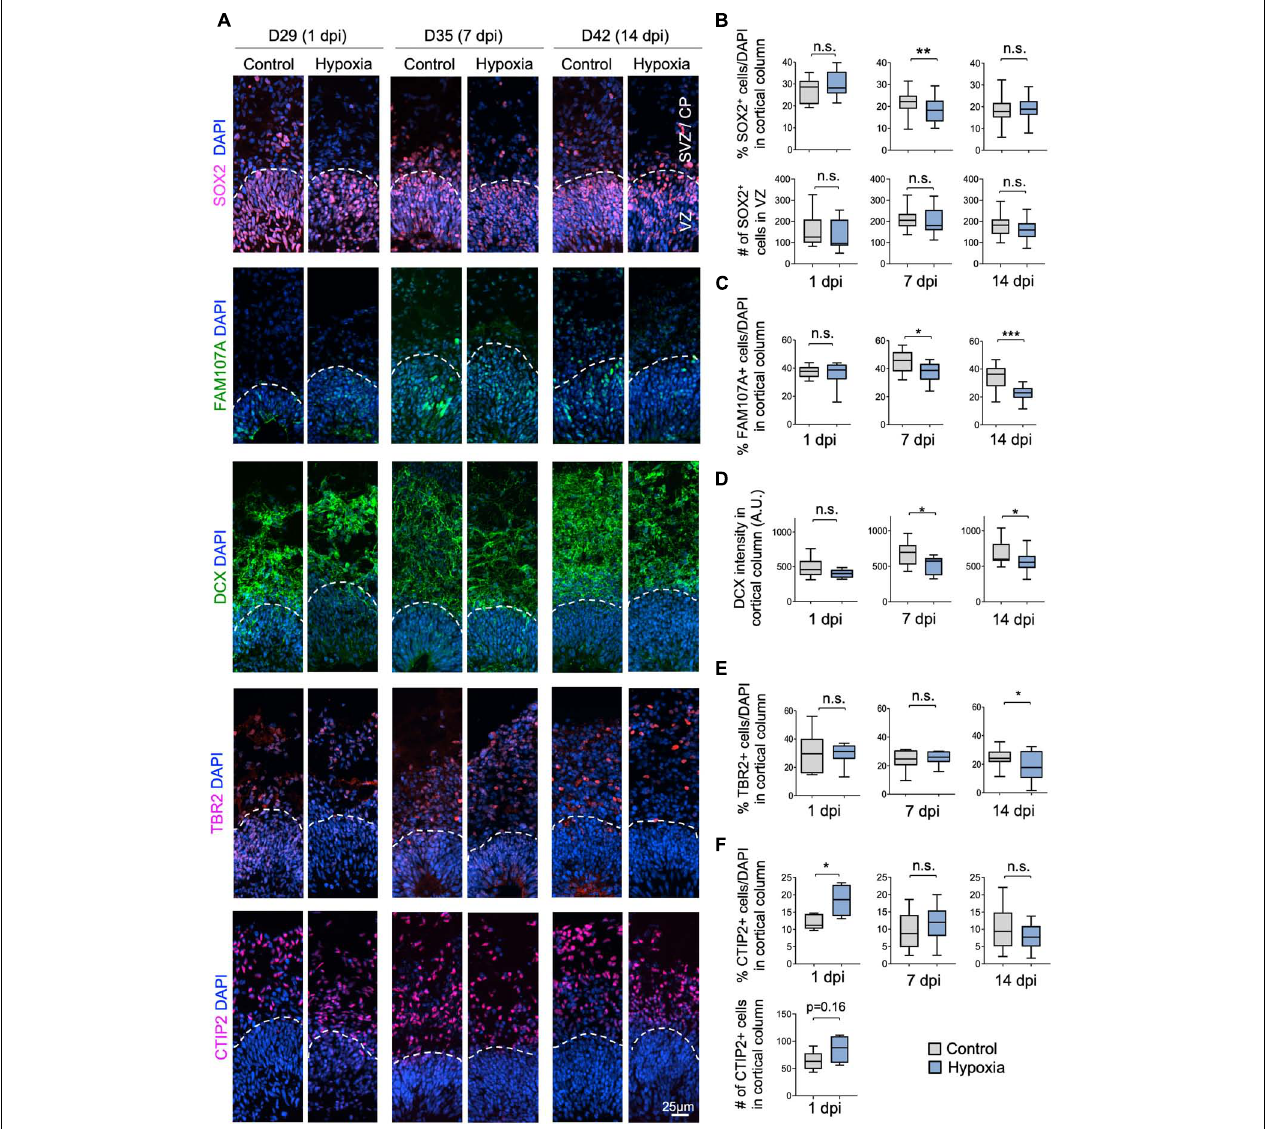
FIGURE 3 | Cellular distinction of different neural populations in response to HI. (A) IF images of representative 100 × 300 µ m cortical columns labeled for the indicated markers at the indicated time points after hypoxia or control. White dashed lines demarcate VZ and outer layers (SVZ/CP). (B) Top graphs: quantifications of the percentage of DAPI + cells across all cortical layers in radial columns that are positive for SOX2 at the indicated time points after hypoxia or control. Bottom graphs: quantifications of the number of SOX2 + cells in VZ-like layer at the indicated time points. Student’s t test, n = 9 organoids from three different batches. (C) Quantifications of the percentage of DAPI + cells in cortical columns that are positive for FAM107A. Student’s t test, n = 9. (D) Quantifications of immunostaining intensity for DCX normalized to unit area (expressed as A.U.). Student’s t test, n = 9. (E) Quantifications of the percentage of DAPI + cells across all cortical layers in radial columns that are positive for TBR2 at the indicated time points after hypoxia or control. (F) Top: quantifications of percentage of DAPI + cells positive for CTIP2 in radial columns. Bottom: quantifications of the number of CTIP2 + cell in radial columns at 1 dpi. Student’s t test, n = 9. A.U., arbitrary unit. ∗ p < 0.05; ∗∗ p < 0.01; ∗∗∗ p < 0.001; n.s., not-statistically